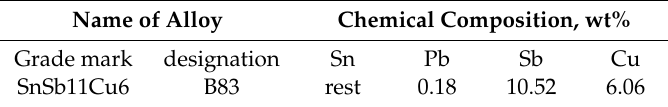
Table 1. Chemical composition of investigated alloy, wt%.